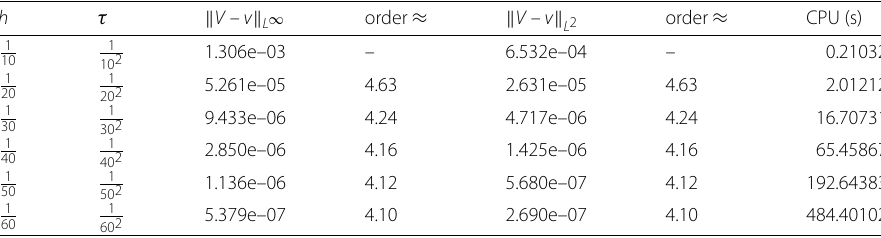
Table 3 Errors and computational orders of compact difference scheme for V